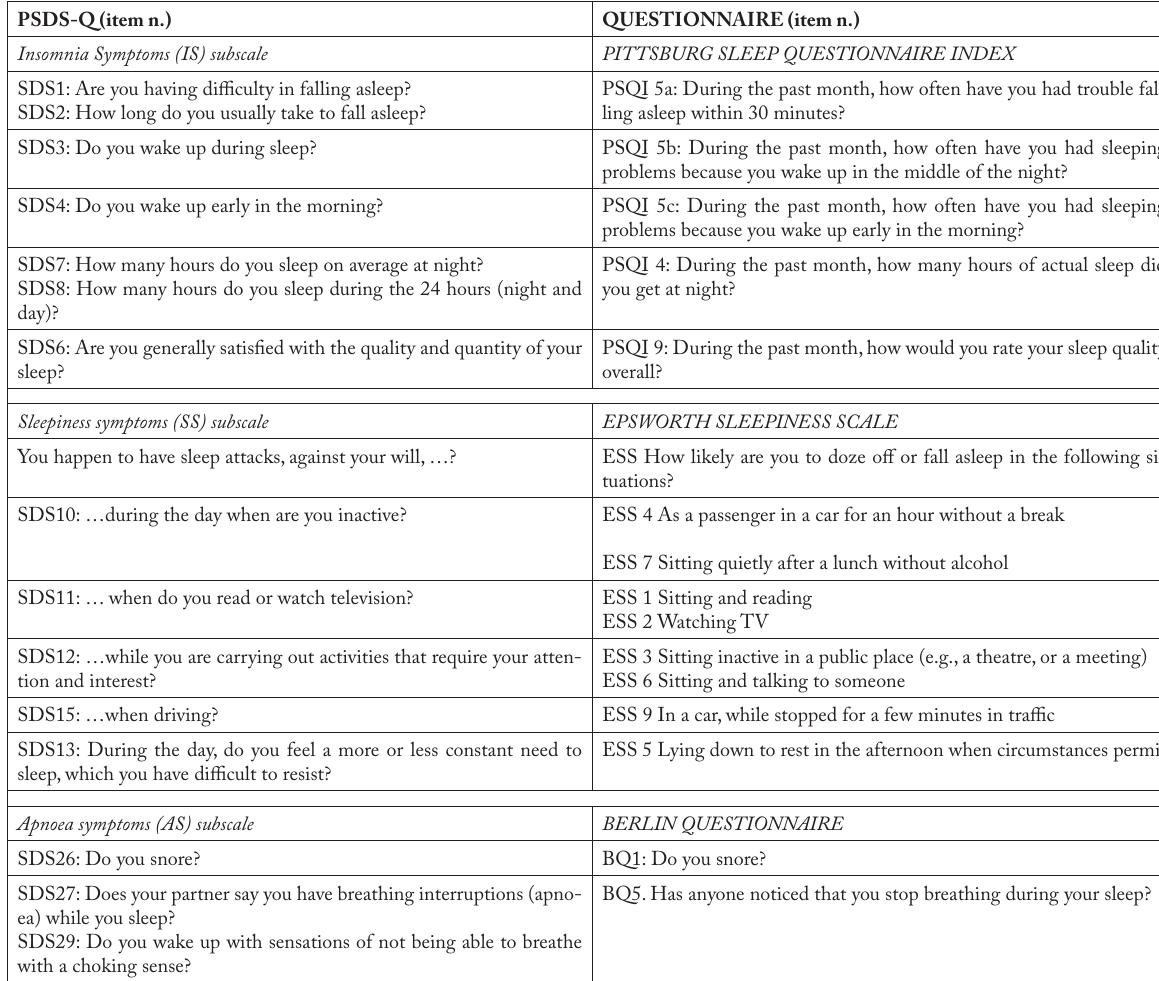
Table 1. Similarities between the Police Sleep Disorders Score Questionnaire (PSDS-Q) and other questionnaires.